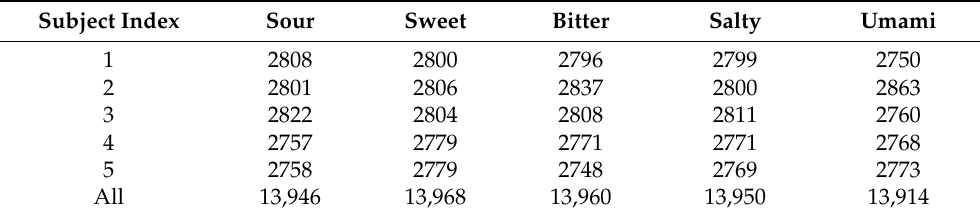
Table 7. Sample amounts for all subjects.